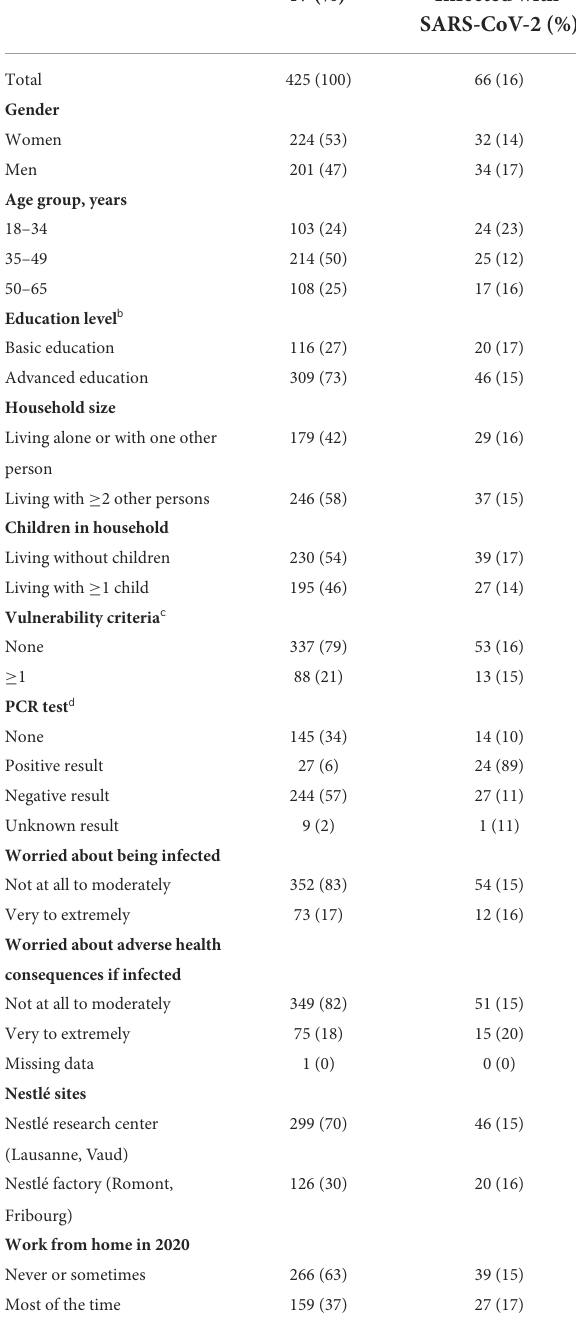
TABLE 1 Characteristics of study participants overall and of those infected with SARS-CoV-2 a